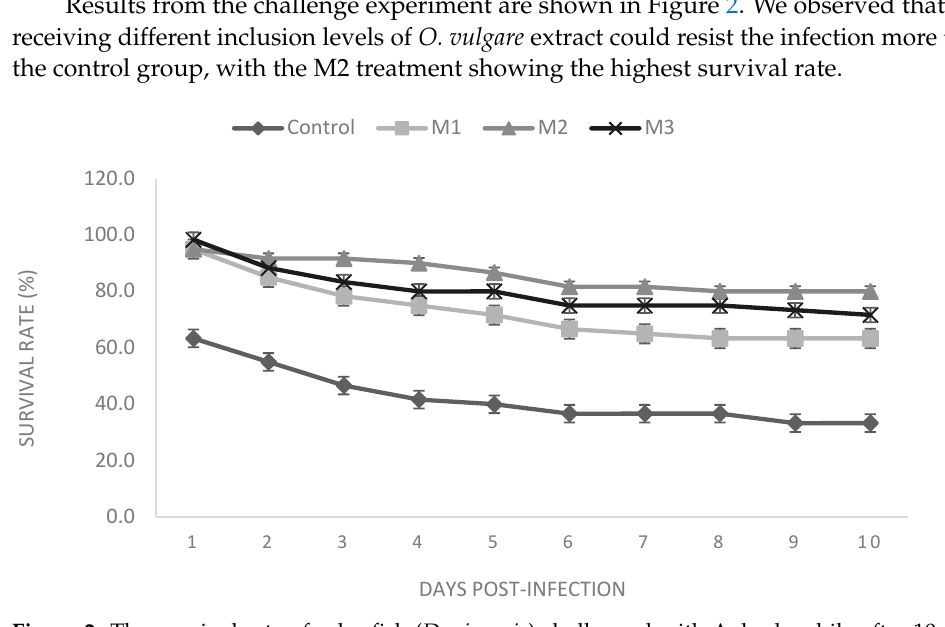
Figure 2. The survival rate of zebrafish ( Danio rerio ) challenged with A. hydrophila after 10 days. Fish were fed on four experimental diets: 0% (control), 0.5% (M1), 1% (M2) and 2% (M3) inclusion of the extract per kg − 1 diet for eight weeks.